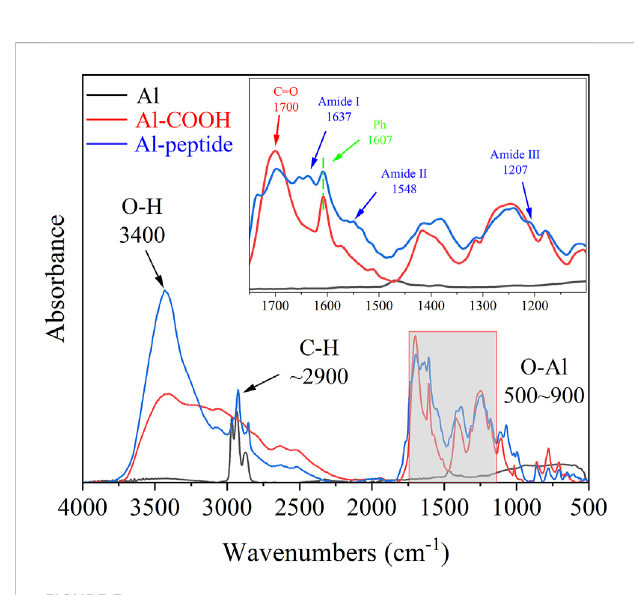
FIGURE 3 FT-IR spectra of Al specimens, Al-COOH specimens, and Al- peptide